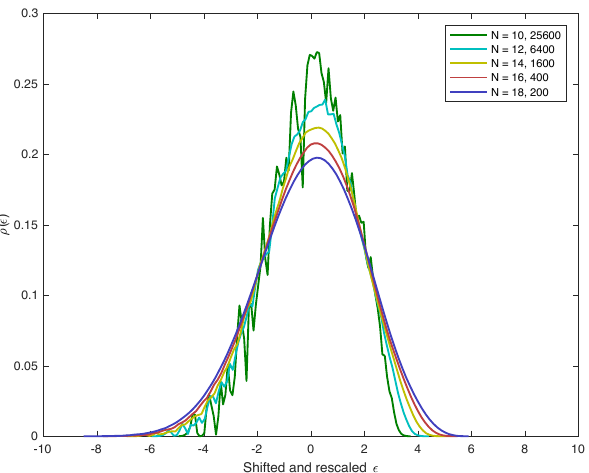
Figure 13 . The spectrum of the XXZ Hamiltonian for N = 10 ; 12 ; 14 ; 16 ; 18, W = 0 : 5 and spin zero